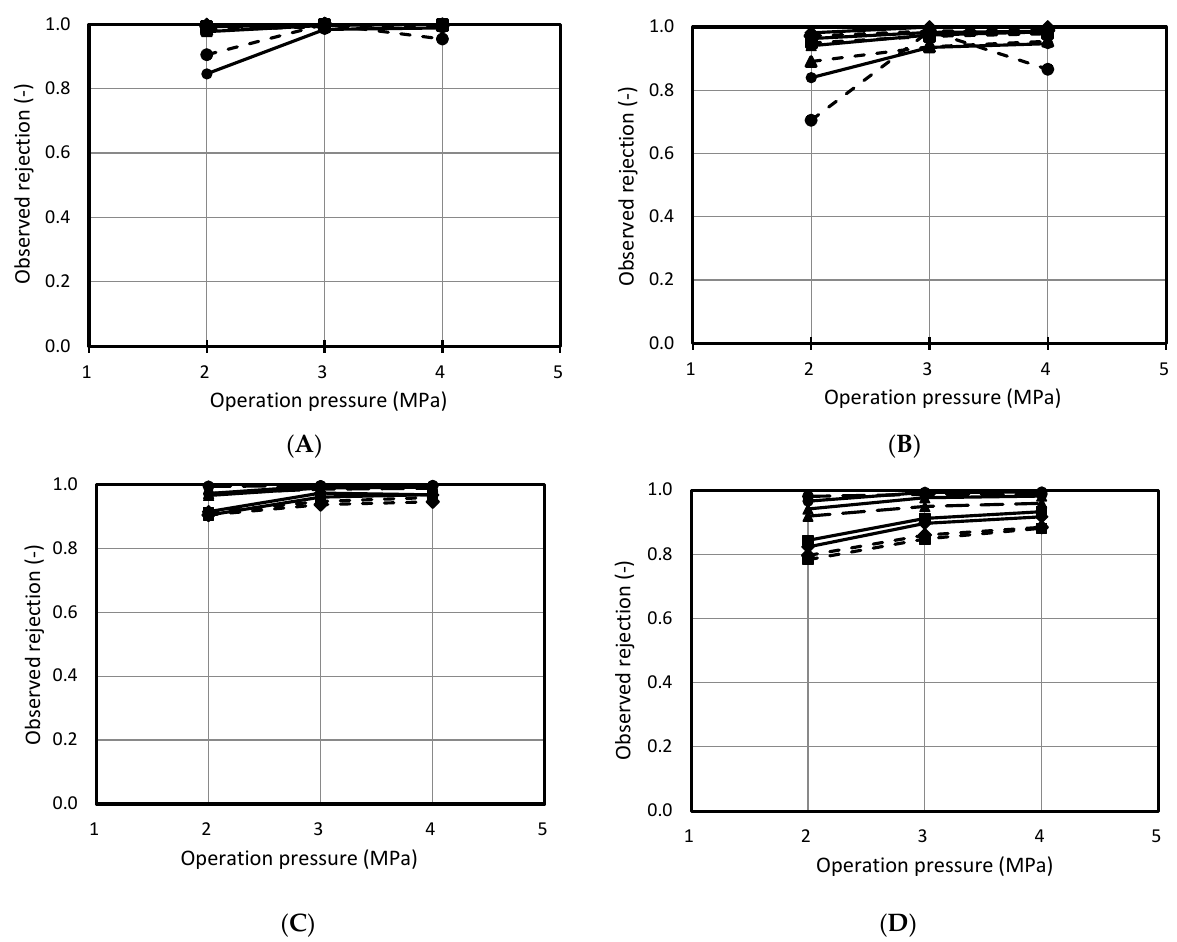
Figure 6. Observed rejection sugars and organic acids against operation pressure. Solid line: fresh cranberry juice, dashed line: UF cranberry juice. ( A ): sugar rejection by NF99, ( B ): sugar rejection by Desal DK, ( C ): organic acid rejection by NF99, ( D ): organic acid rejection by Desal DK. Conditions of nanofiltration: operating pressure: 3 MPa, operating temperature: 25 °C, feed flow rate: 7.5 L/min. : pH 2.5, : pH 3.5, ▲ : pH 4.5, : pH 5.5.